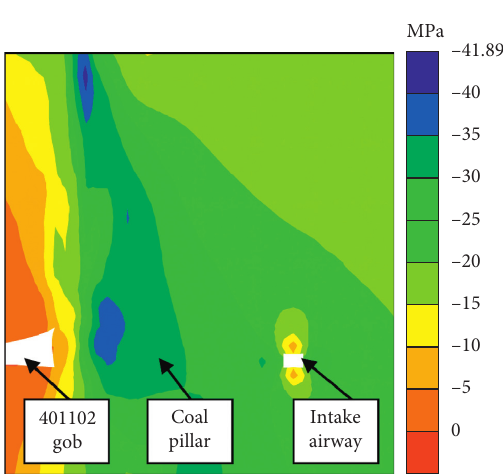
Figure 3: Vertical stress contour in intake airway.